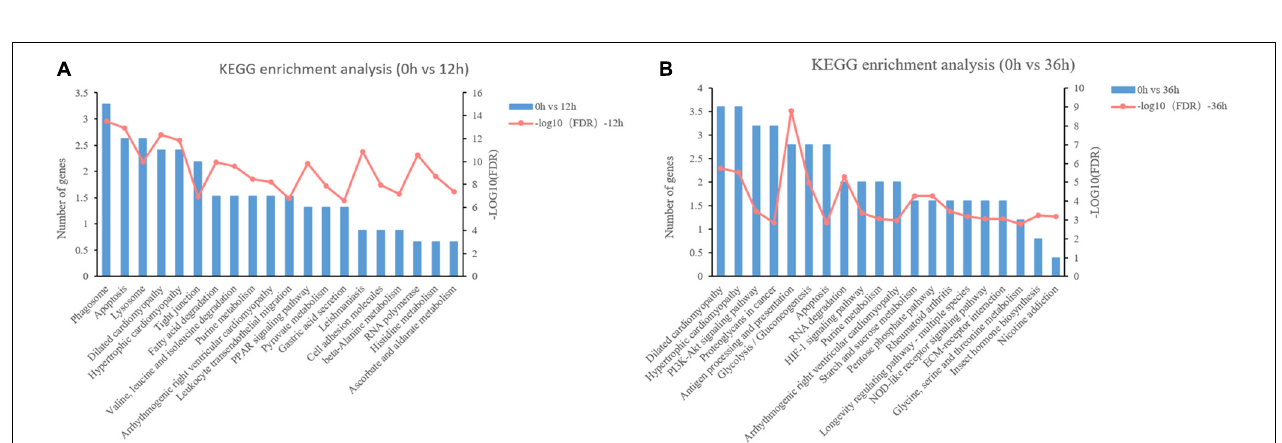
FIGURE 6 | KEGG enrichment analysis of differentially expressed proteins (DEPs) in proteome. (A) KEGG pathway enrichment analysis of DEPs in 0 vs. 12 h. (B) KEGG pathway enrichment analysis of DEPs in 0 vs. 36 h.